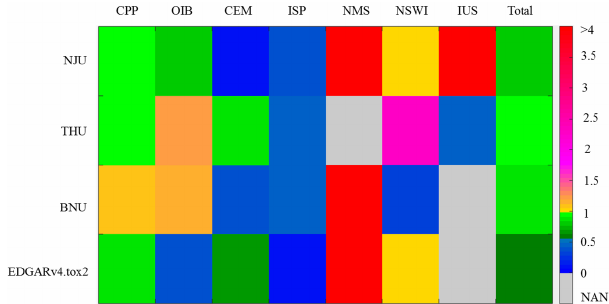
Figure 1. The ratios of estimated Hg emissions for Jiangsu and 2010 in global/national inventories to that in the provincial inven- tory for selected sources and anthropogenic total.